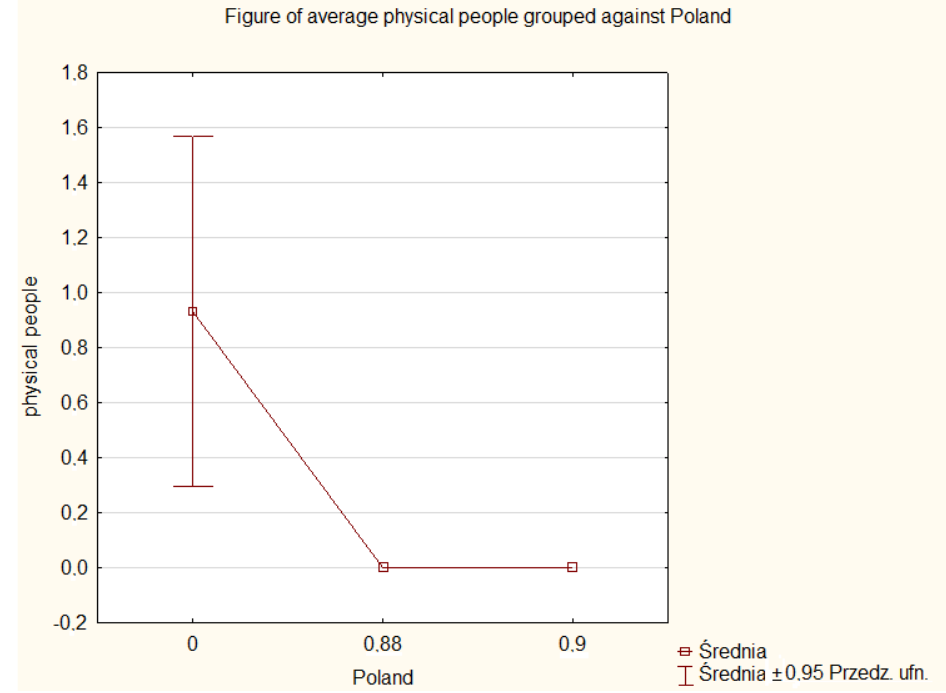
Figure 25. Poland in the opinion of entrepreneurs (hydrogen activities).